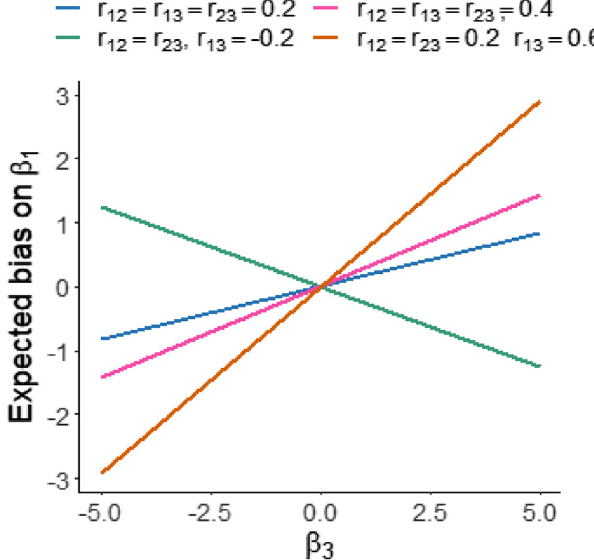
ˆ β (cid:3) − β 1 1 ) as a function of